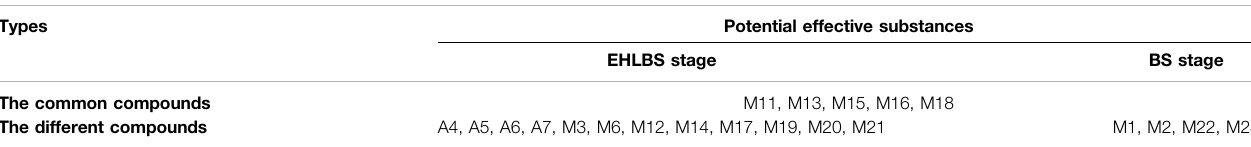
TABLE 7 | The comparative analysis of potential effective substances of PRR in EHLBS stage and BS